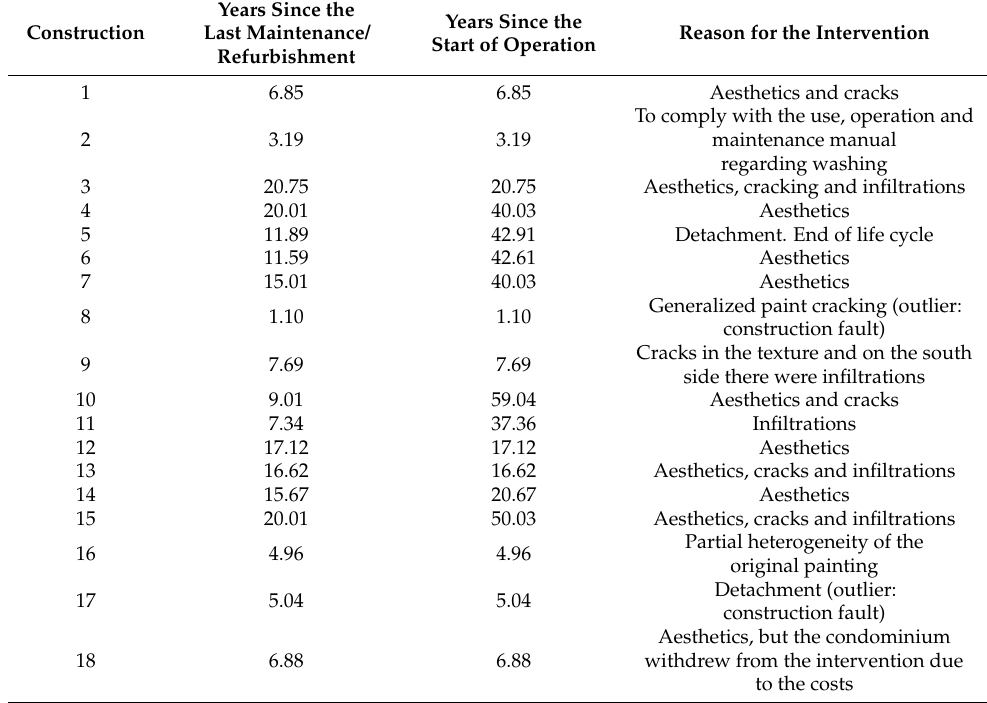
Table 1. Distribution of the sample collected with the reasons that led to the contracting of mainte- nance